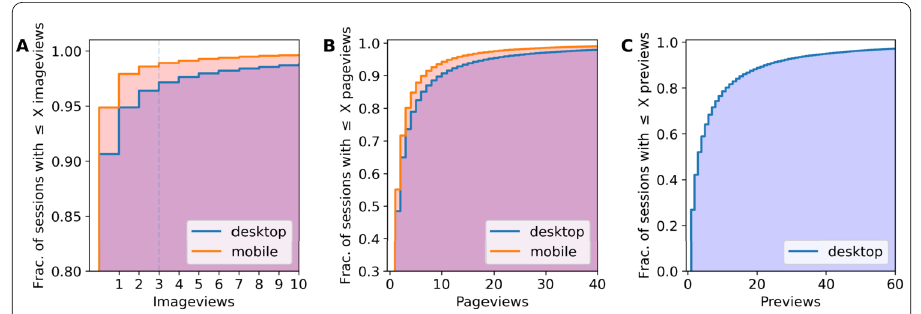
Figure 4 Cumulative distributions of number of sessions by ( A ) imageviews, ( B ) pageviews, and ( C ) previews partitioned by desktop (in blue) and mobile device (in orange). Page previews are available only on desktop